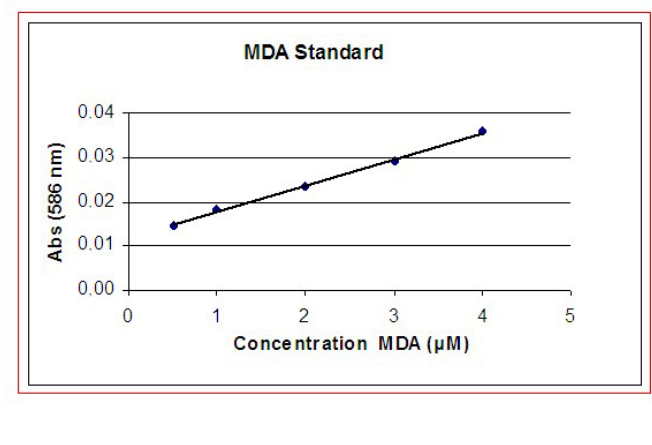
Figure 5. Production of MDA plotted vs. absorbance with the formation of a standard reference